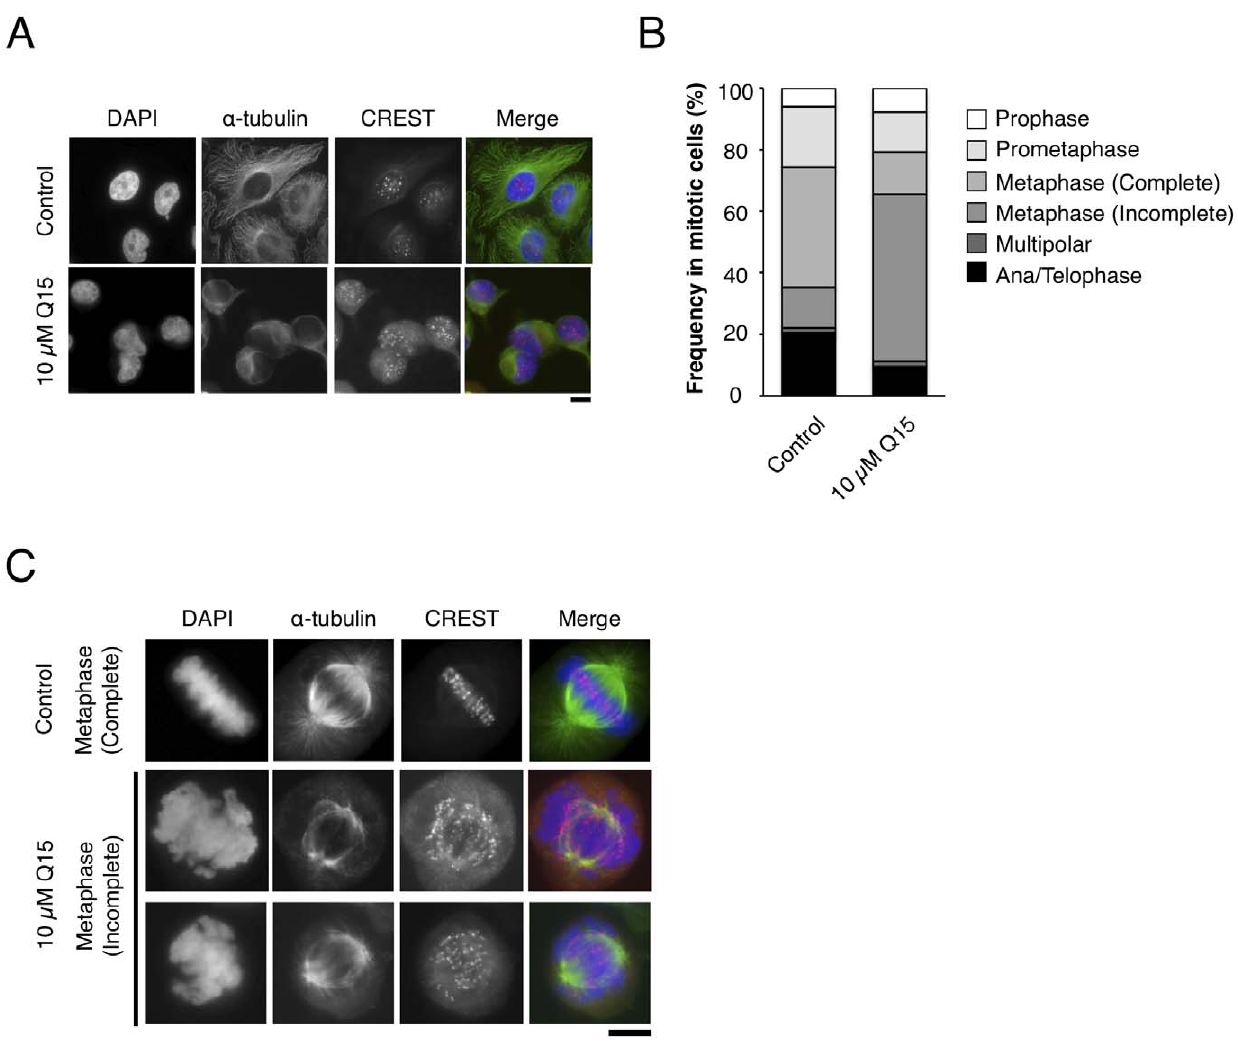
Figure 6. Q15 induces abnormal chromosome segregation. HeLa cells were treated with DMSO (Control) or 10 m M Q15 for 24 h, and immunofluorescence labeling with an antibody against a -tubulin (green) and CREST (red) was performed. DNA was stained with DAPI. (A) Representative images of interphase cells are shown. Bar, 10 m m. (B) Percentages of cells at different stages in mitotic populations are shown. The mitotic stages and alignment defects were judged by DAPI staining. (C) Representative metaphase cells are shown. Q15-treated cells display a dramatically high frequency of metaphase cells with incompletely aligned chromosomes. Bar, 10 m m.